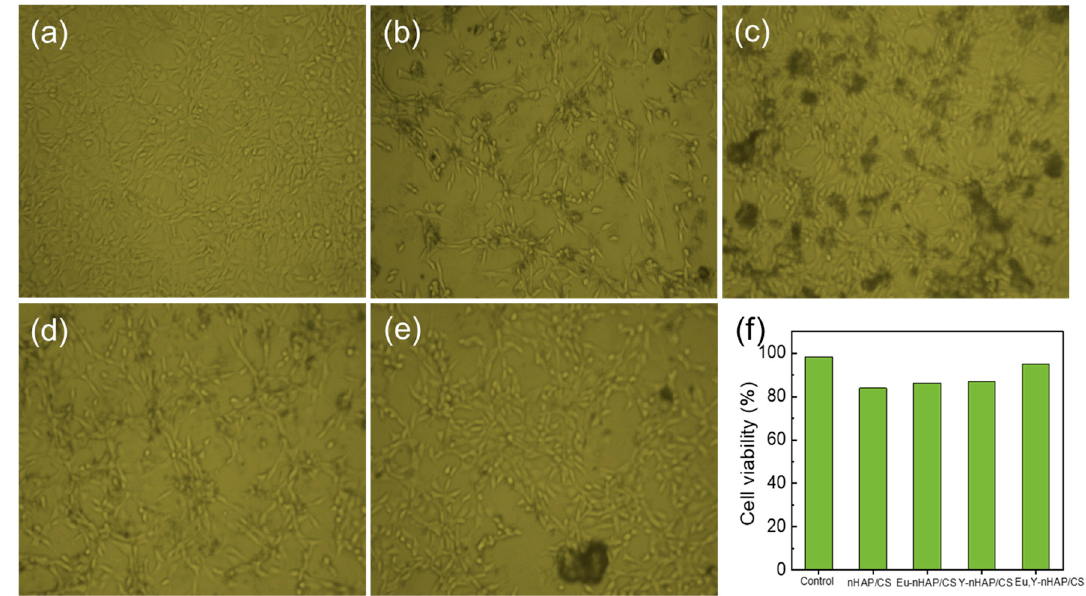
Figure 7. Optical microscopy images (magnification: × 20) of ( a ) control, ( b ) nHAP/CS, ( c ) Eu- nHAP/CS, ( d ) Y-nHAP/CS, and ( e ) Eu,Y-nHAP/CS composites treated with the NIH 3T3 cell line and ( f ) cell viability of the samples.